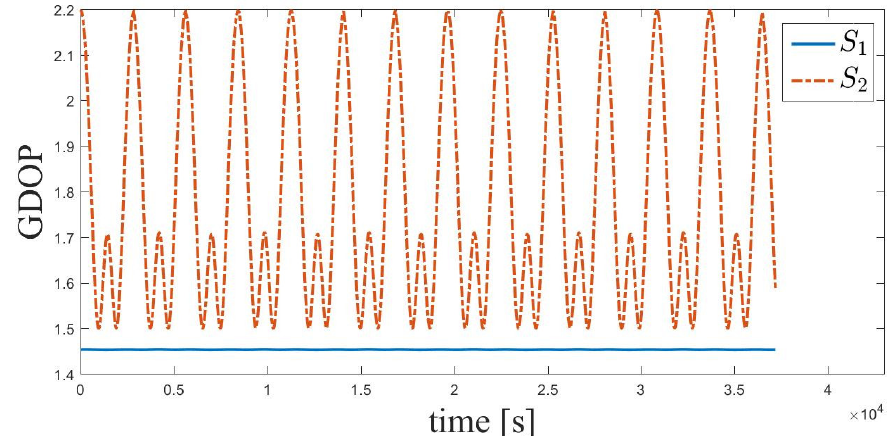
Figure 10. Time history of GDOP of and .